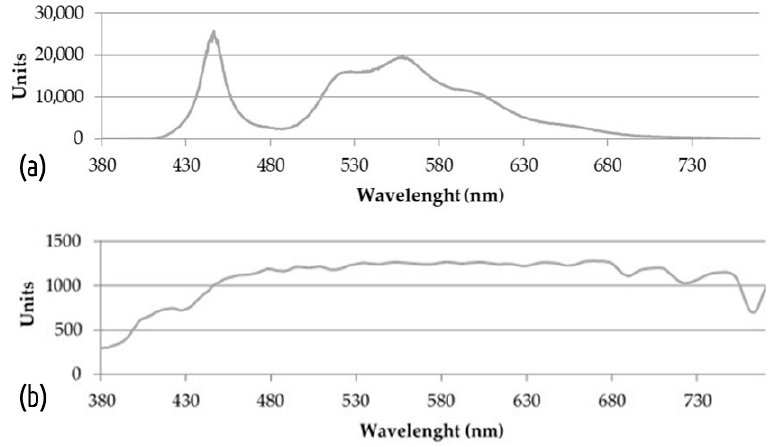
Figure 2. ( a ) Spectrum of LED lights used for this study, ( b ) Sun’s spectrum, during noon.